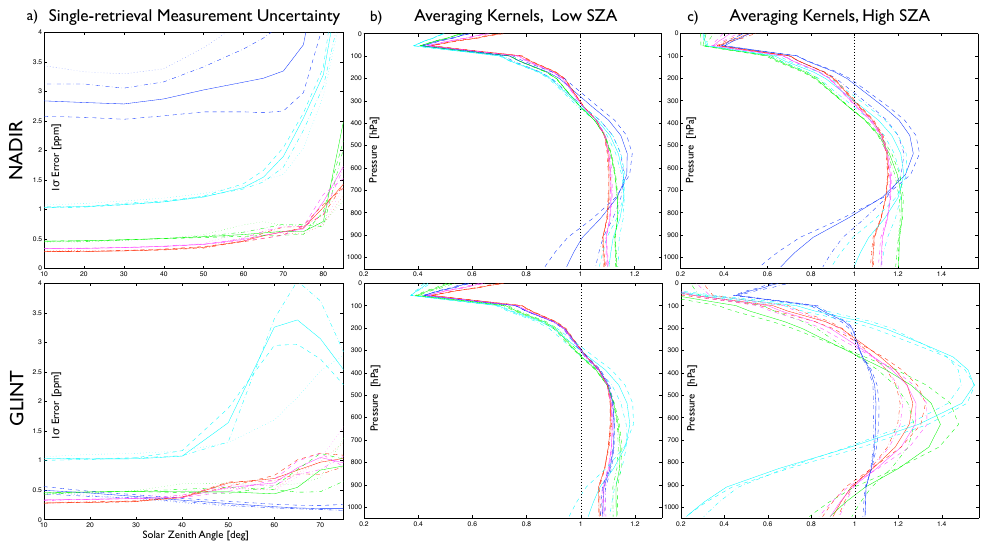
Fig. 3. A summary of (a) the single-sounding OCO X CO uncertainties [ppm] and (b) and (c) normalized averaging kernels (AKs) for 2 nadir (top) and glint (bottom), from B¨osch et al., for five surface types (conifer, green; desert, red; sparse vegetation, magenta; snow, cyan; and ocean, blue) and for four 760nm aerosol ODs (0.00, dotted; 0.10, dot-dash; 0.20, solid; and 0.30, dashed). The AKs in (b) have been averaged over SZAs of 20 ◦ − 50 ◦ ; those in (c) over 60 ◦ − 75 ◦ for glint and 60 ◦ − 80 ◦ for